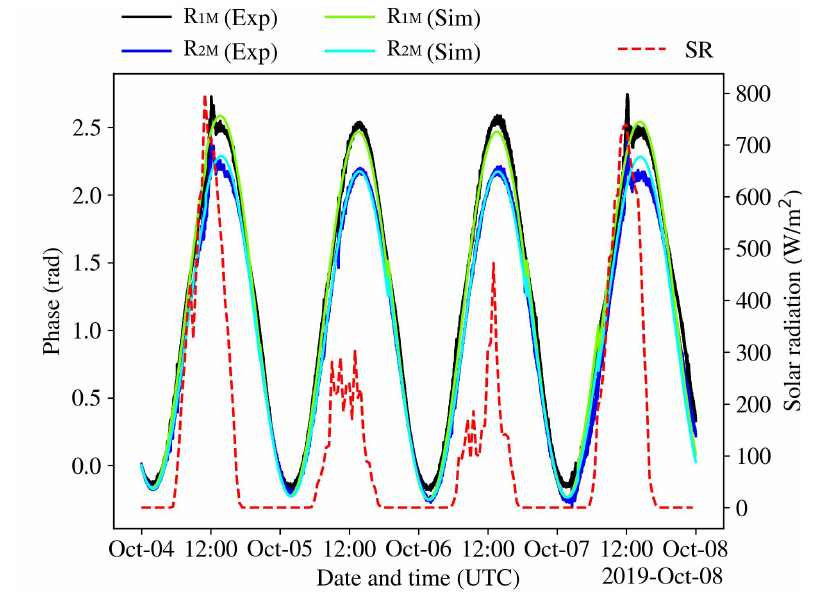
Figure 6. Detail of four days of interferometric measurements. R 1M and R 2M correspond to the baselines formed by the main antenna and the Secondary 1 and Secondary 2 receivers, respectively. Phase measurements (experimental and simulated) are referenced to the left axis. Solar Radiation (SR) measurements are referenced to the right axis. The experimental data, obtained with the interferometric measurement system, are compared against the simulated data, obtained from the North American Aerospace Defense Command (NORAD) Two-Line Element (TLE) information and the geosynchronous orbital model. During sunny days (SR higher than 600 W/m 2 ), the troposphere is turbulent, which increases the interferometric phase random fluctuations. Moreover, temperature effects on the experimental measurements are very significant when the solar radiation is highest, causing deviations from the simulated data. On the other hand, during the night and cloudy days (SR lower than 600 W/m 2 ), the phase measurements are cleaner, showing a better fit between experimental and simulated